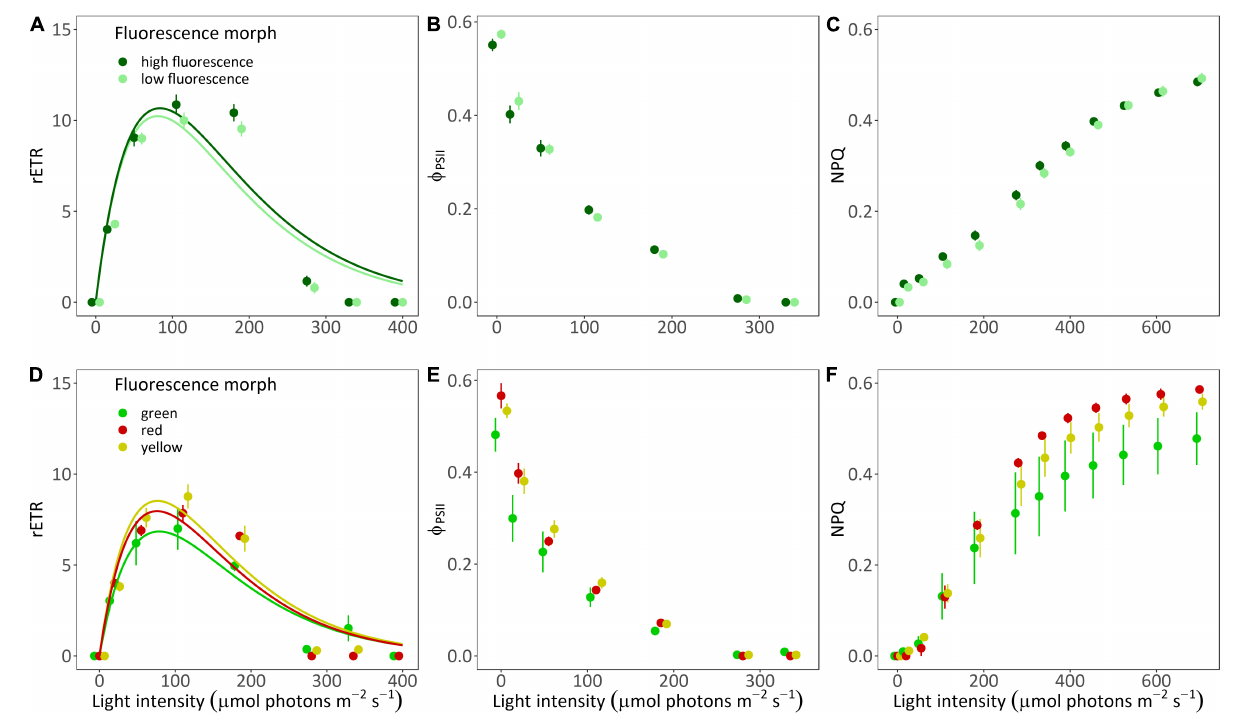
FIGURE 3 | Rapid light curves of two mesophotic coral species. Fitted (solid lines) and mean (circles) ± SE (error bras) of rETR values (A,D) , effective quantum yield [ (cid:56) PSII ; (B,E) ], and non-photochemical quenching [NPQ; (C,F) ] of high fluorescence (dark green; n = 5) and low fluorescence (light green; n = 5) morphs of Alveopora ocellata (A–C) , and green (green; n = 2), red (red; n = 1), and yellow (yellow; n = 2) fluorescence morphs of Goniopora minor (D–F) . TABLE 1 | Photosynthetic parameters derived from photosynthesis-irradiance (P-E) curves under blue illumination.